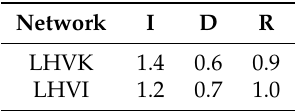
Table 3. Ratio of